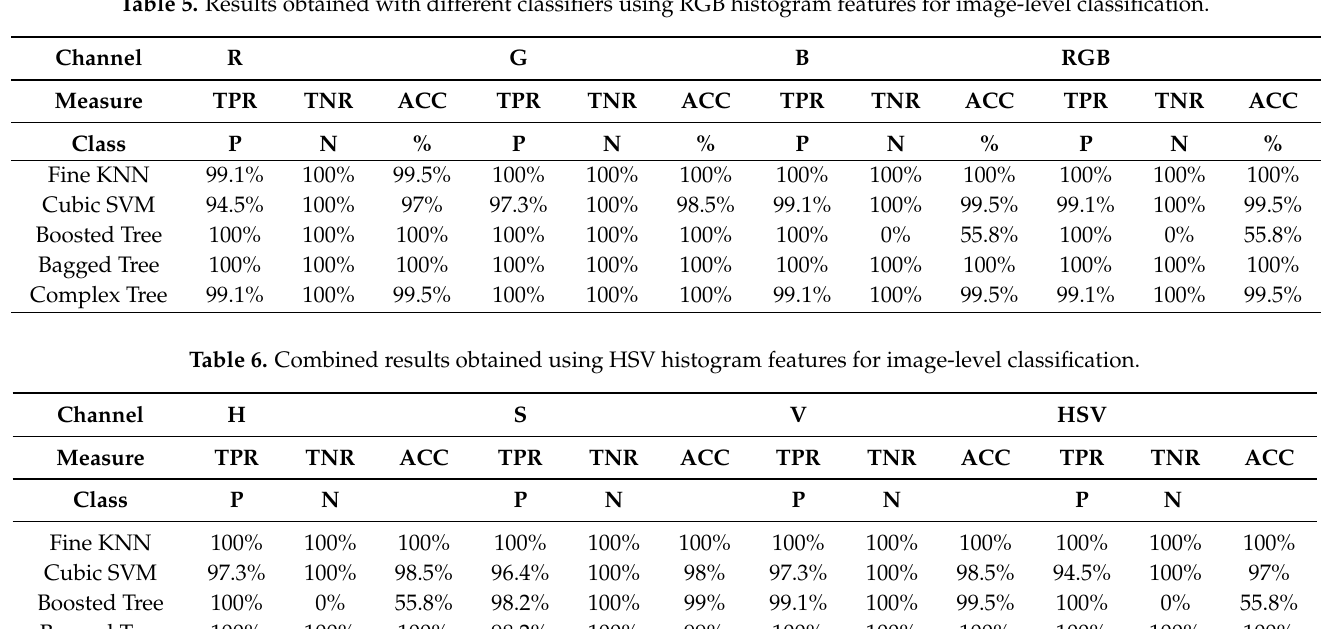
classification results on testing images. Ranks obtained using the Kruskal-Wallis Test based on the mean accuracy and the performance deviating from the mean of one classifier to the mean of other classifiers using hybrid features are presented in Table 9. Table 5. Results obtained with different classifiers using RGB histogram features for image-level classification.